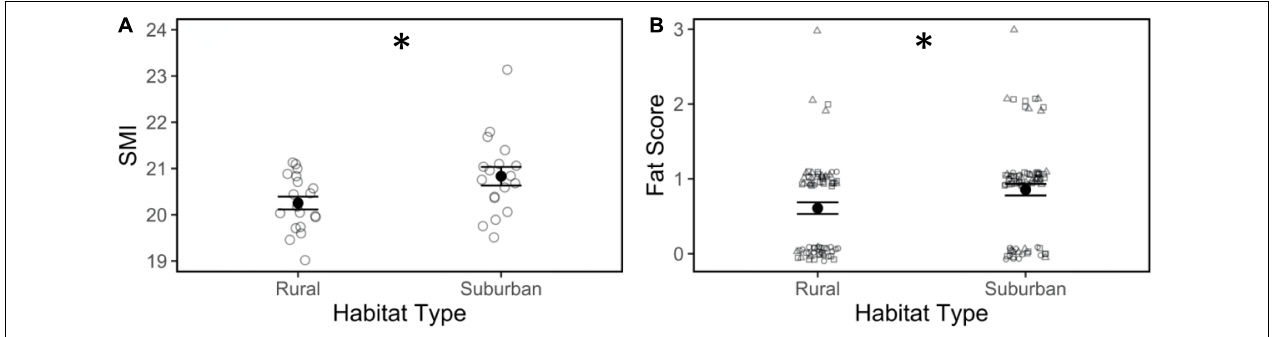
FIGURE 1 | Scaled mass index (SMI; A ) and fat score (B) of male song sparrows from rural and suburban habitats. Closed circles and whiskers are mean ± SE; open shapes are measurements of individuals birds; (B) open squares: 2016; open circles: 2017; open triangles: 2020; asterisk denotes difference at p < 0.05. TABLE 1 | Physiological measurements of male song sparrows collected from rural or suburban habitats. Rural Suburban Habitat:| t | value Time of day: | t | (mean ± SE) (mean ± SE) ( p -value) value ( p